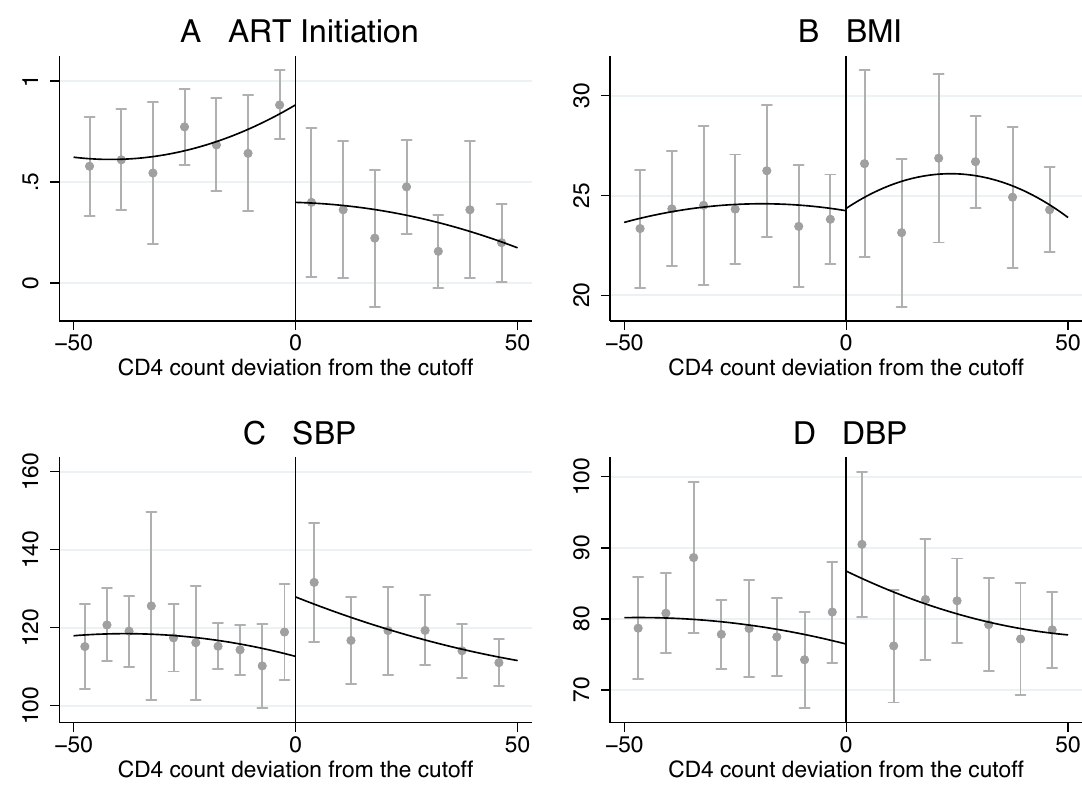
Figure 3. Mean treatment initiation, BMI, SBP and DBP by CD4 cell count bins with 95% confidence intervals. The approximation is a second-order polynomial function differing on both sides of the threshold.